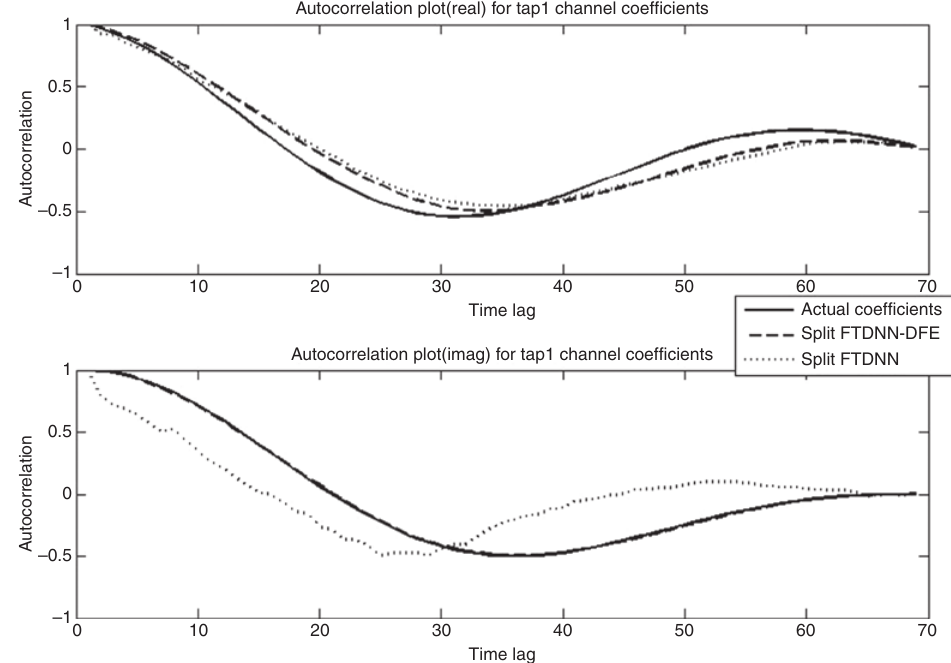
Figure 16: Autocorrelation Plot for Case